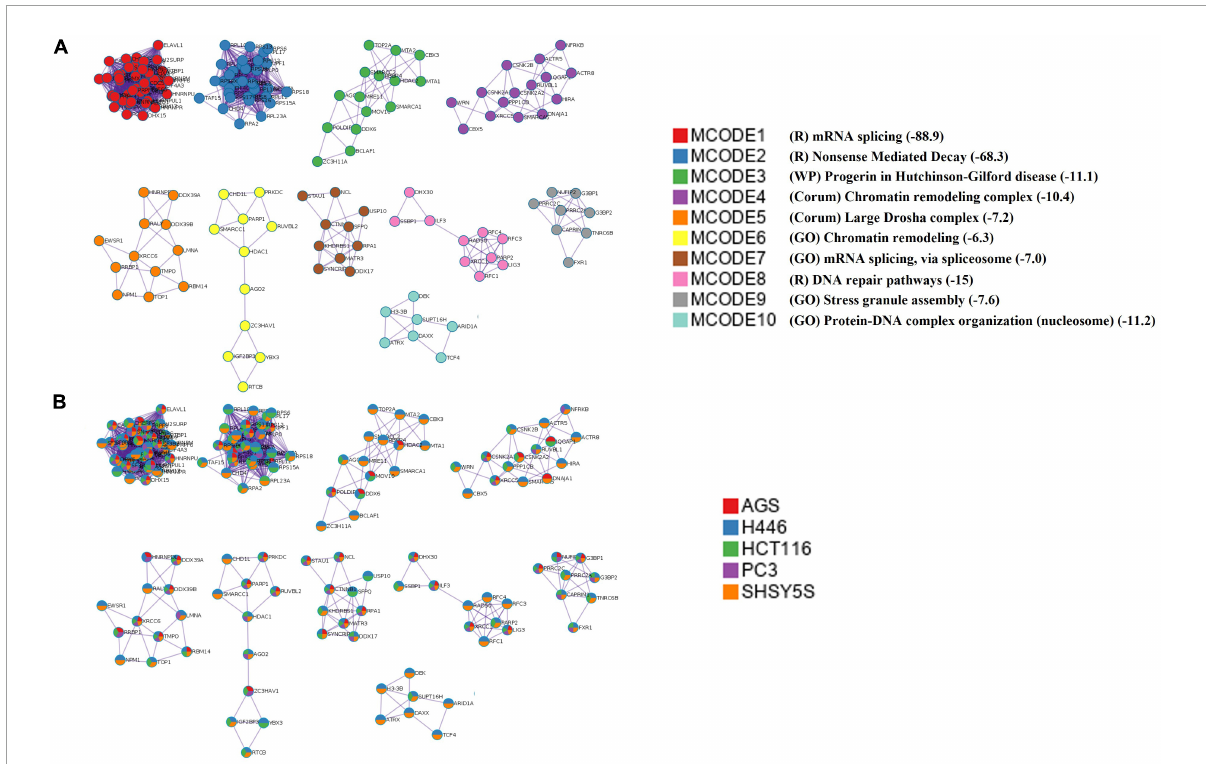
FIGURE3 Top 10 significant protein-protein interaction networks. (A) The top 10 MCODE complexes formed by the 520 proteins from the pulled list of the 5 analyzed cell lines. The PPI included the mRNA splicing pathway (MCODE1 and 7), the nonsense-mediated decay (NMD) (MCODE2), the effect of progerin on the involved genes in Hutchinson-Gilford Progeria Syndrome (MCODE3), the INO80 chromatin remodeling complex (MCODE4), Large Drosha complex (MCODE5), chromatin remodeling complex (MCODE6), DNA repair pathways (MCODE8), stress granule assembly (MCODE9), and protein-DNA complex subunit organization (MCODE10). The mRNA splicing pathway was the most significant. P -value in Log 10 are given in parenthesis in the Legend and in Supplementary Table 3 . In the Legend R = Reactome, WP = WikiPathways, GO = GO term. (B) The network nodes are displayed as pie. Color code for pie sector represents a protein list from each of the five analyzed cell lines. The keys codes for the MCODEs shown in this figure are listed in Supplementary Table 3 , together with their correspondent p